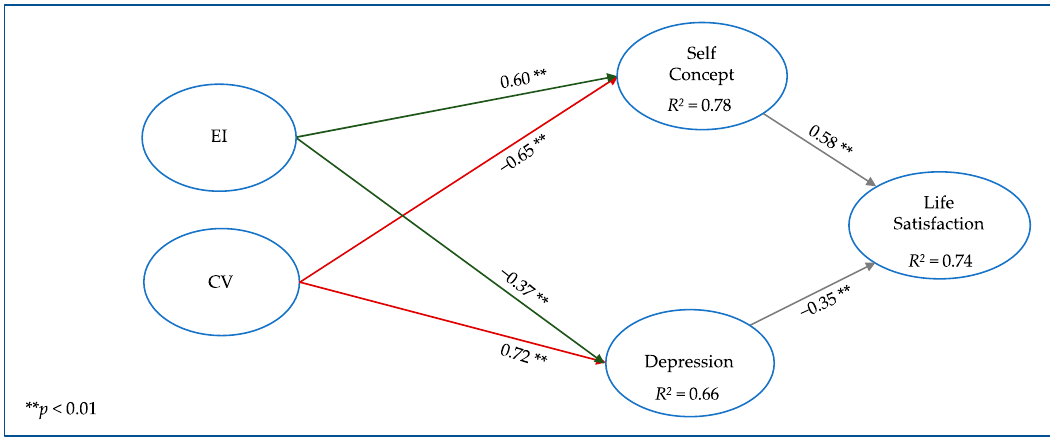
Figure 2. Model 2: Relationships between cybervictimization (CV) and emotional intelligence (EI) with emotional adjustment constructs. emotional adjustment constructs.